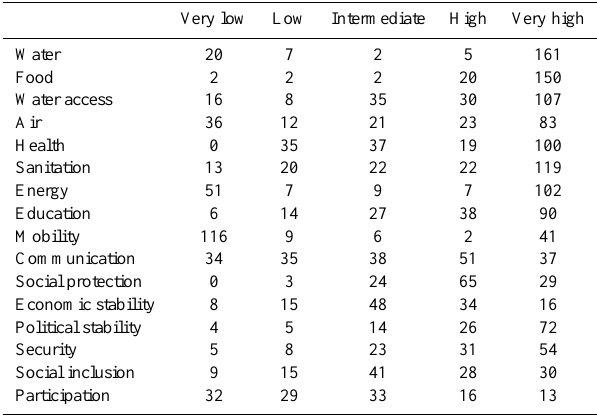
Table A1. Summary of results for each variable, showing the num- ber of countries in each class. Classes correspond to 0.2